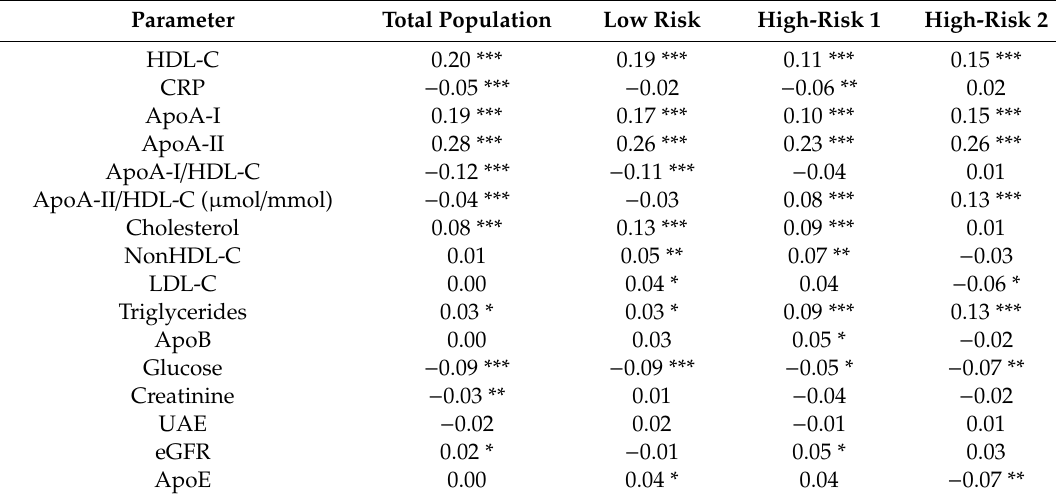
Table 2. Spearman correlation coe ffi cients of PON1 with biomarker levels for total, LR, HR1, and HR2